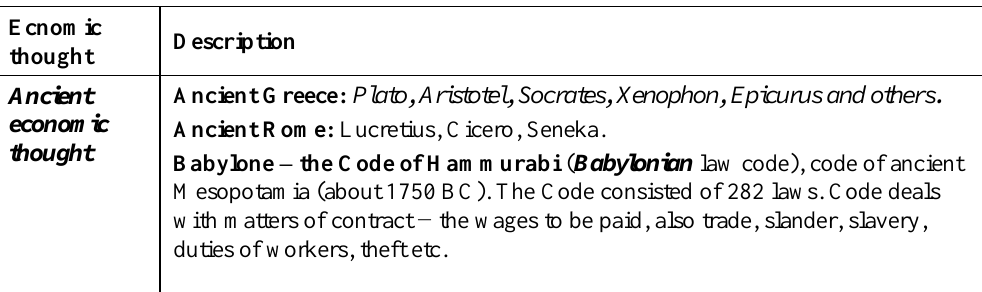
Table 4. Main economic thoughts and schools (compiled by